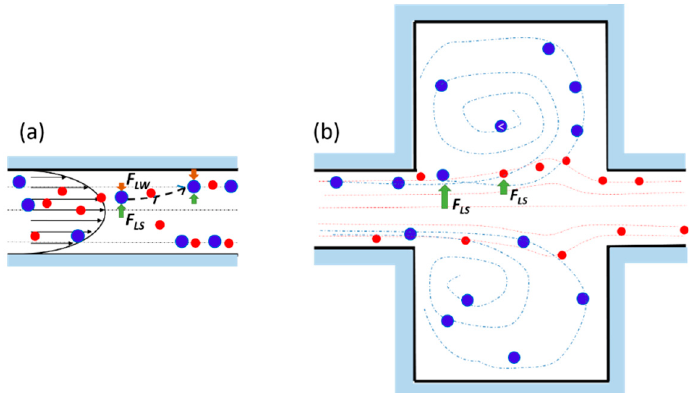
Figure 2. ( a ) The particles randomly flowing in a straight channel undergo two opposite lift forces: The wall effect lift force F LW and the shear-gradient lift force F LS , resulting in lateral equilibrium positions depending on the channel section. ( b ) At the entrance of the reservoir, the particles experience F LS , which increases with their size: The larger blue particles are pushed toward the vortex center and trapped, meanwhile the smaller red ones flow in the main stream. Adapted from [83].